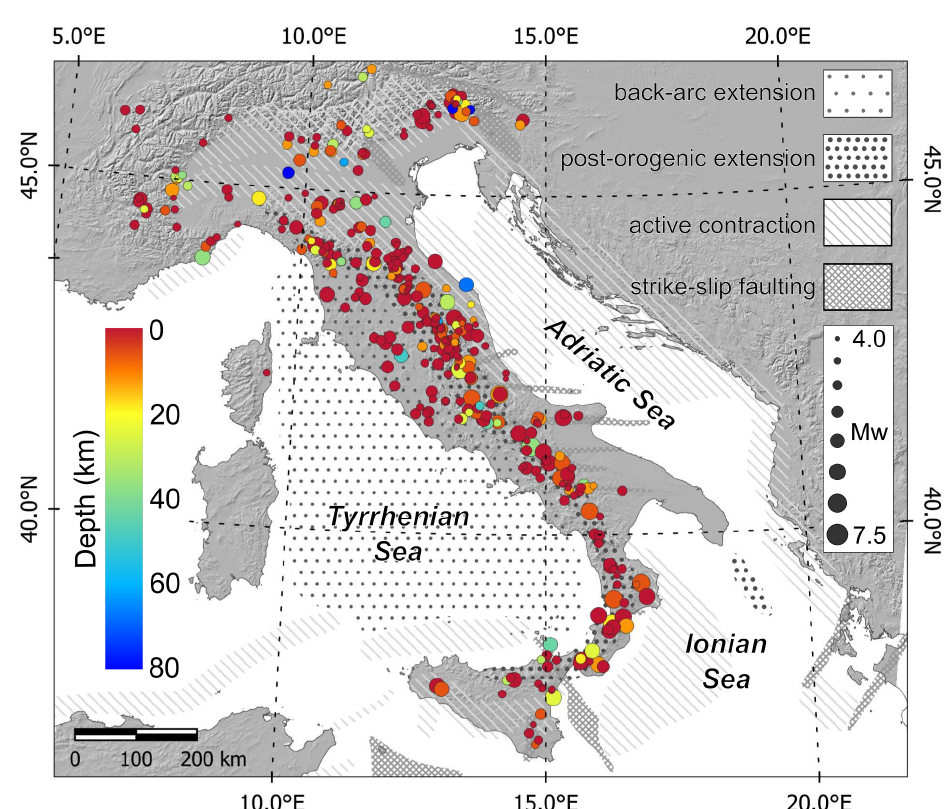
Figure 11. Estimated depth calculated using our approach (color-coded) for the 206 earthquakes in the analyzed set, shown with symbol size scaled with the magnitude calculated in this work. The areas with different patterns indicate active tectonic domains that exist in the Italian Peninsula and surrounding areas (same as Fig. 1) (from Vannoli et al.,